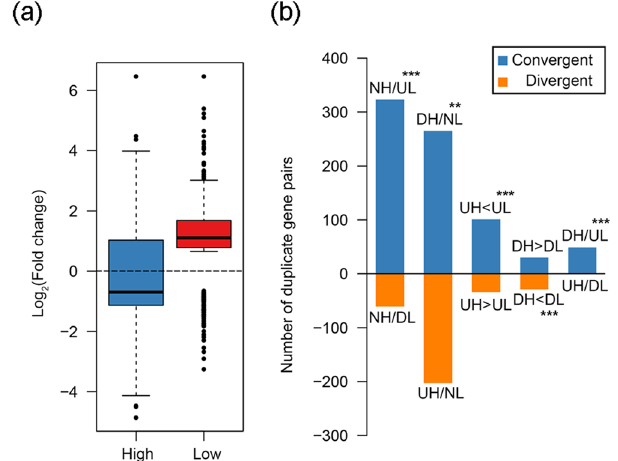
Figure 3. Changes in expression by the higher and lower expression copy-groups, respectively, of all identified rice duplicate genes with CG-only methylation ( a ), and convergent versus divergent expression changes between copies of the duplicate genes with CG-only methylation ( b ), due to loss of BCGM in the mutant. ( a ) The y axis shows fold changes of expression level between WT and mutant by the higher and lower expression copy-groups, respectively, of all identified rice duplicated genes. The dashed black line denotes fold change = 1, which divides the boxplots into two parts. Distribution of gene numbers between the upper and lower parts was tested by binomial exact test, which indicated that the two parts contained significantly different numbers of genes for both the higher expression copy group ( p value = 0.01199) and the lower expression copy-group ( p value < 2.2e-16). ( b ) Based on changing direction (up- versus down-regulation) and magnitude (higher versus lower) in expression by the two copies of each analyzed duplicate, the duplicated genes that showed expression differences between WT and mutant can be categorized into10 distinct groups, which can be combined into two classes according to consequences of the changes with respect to reducing or augmenting expression differences between duplicate copies, i.e., convergent and divergent (see main text for details). The y axis shows the number of duplicate genes in each of the 10 groups. A binomial exact test was performed to test for statistical differences in convergence versus divergence in each comparison. Aasterisks denote statistical significance: * , ** and *** are P values < 0.05, 0.01and 0.001,